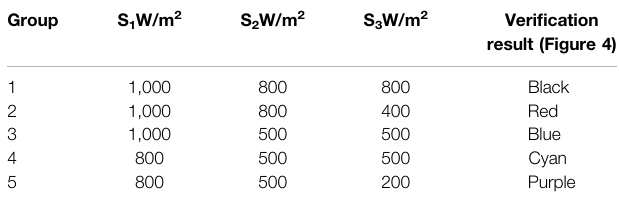
TABLE 3 | PV array under shielding